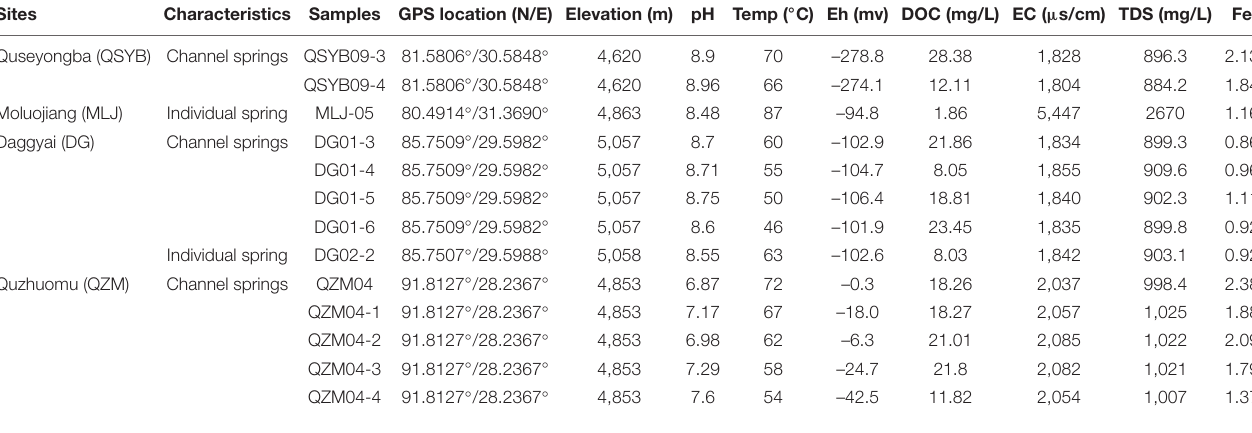
TABLE 1 | Geographical and geochemical parameters of the investigated hot springs in this study.